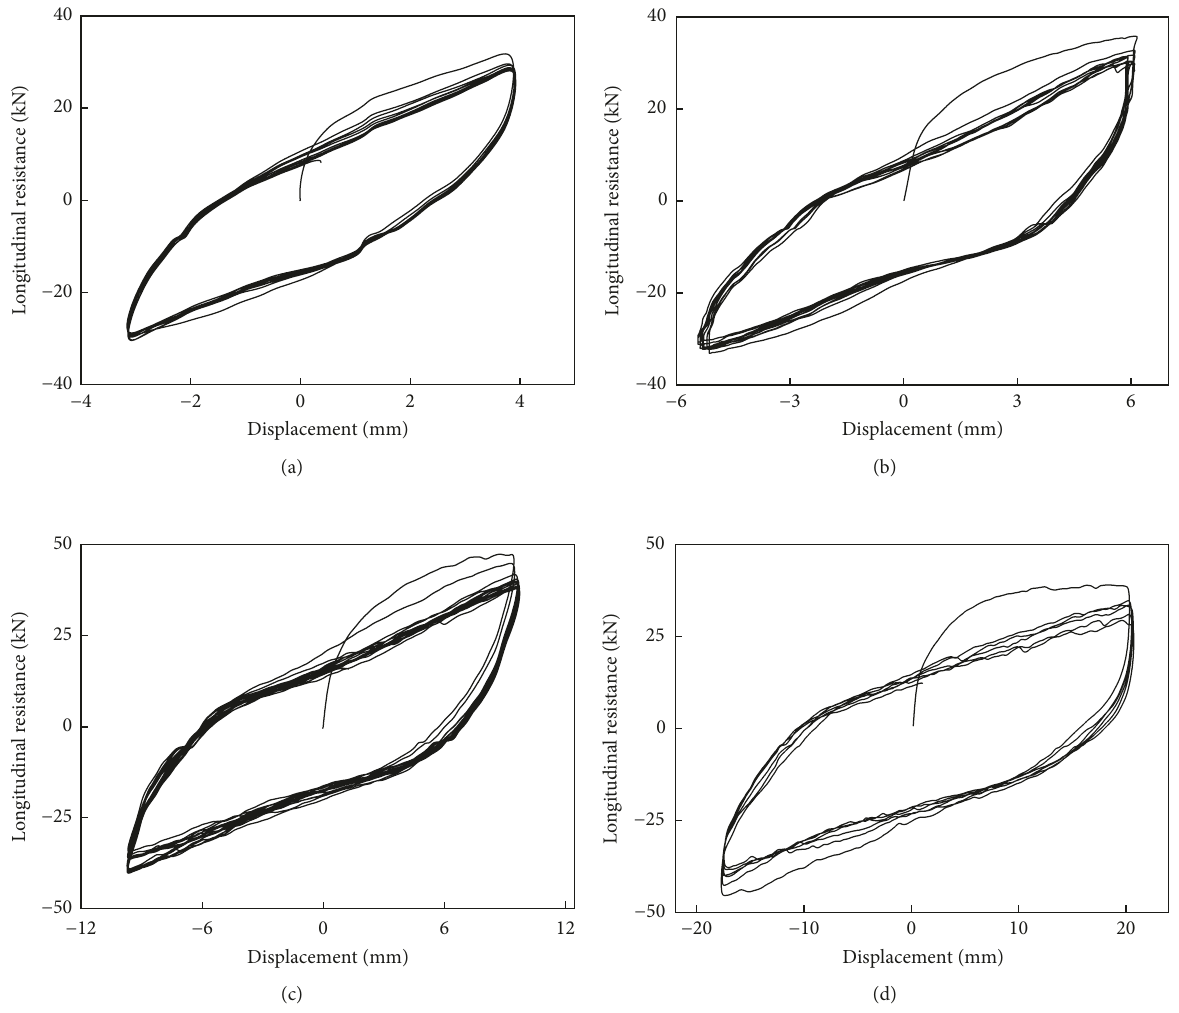
Figure 5: Resistance-displacement hysteretic curves of ballast bed under different displacement amplitudes: (a) 4mm, (b) 6mm, (c) 10mm, and (d)